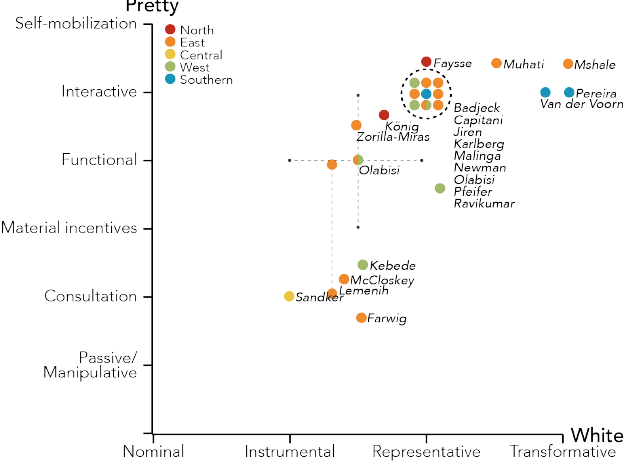
Fig. 2. Assigned participation typologies for each reviewed paper based on typology features provided by Pretty (1995) and White (1996). Colors indicate the geographical location of the study in sub-Saharan Africa, and labels are based on the first author’s name. Dashed lines on specific points indicate that those studies are categorized in two typologies (e.g., Lemenih used both consultational and functional participation, but not participation for material incentives). The dashed circle encloses a cluster of studies that are all classified as interactive and